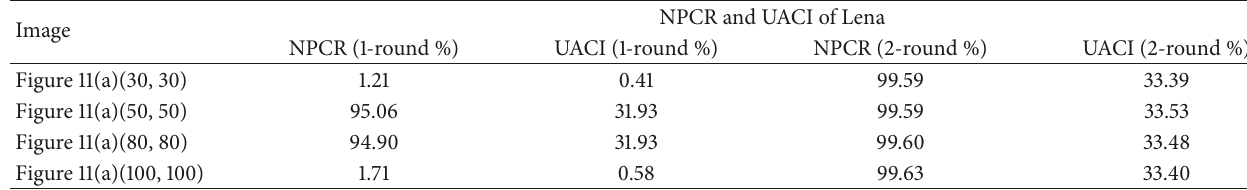
NPCR and UACI of